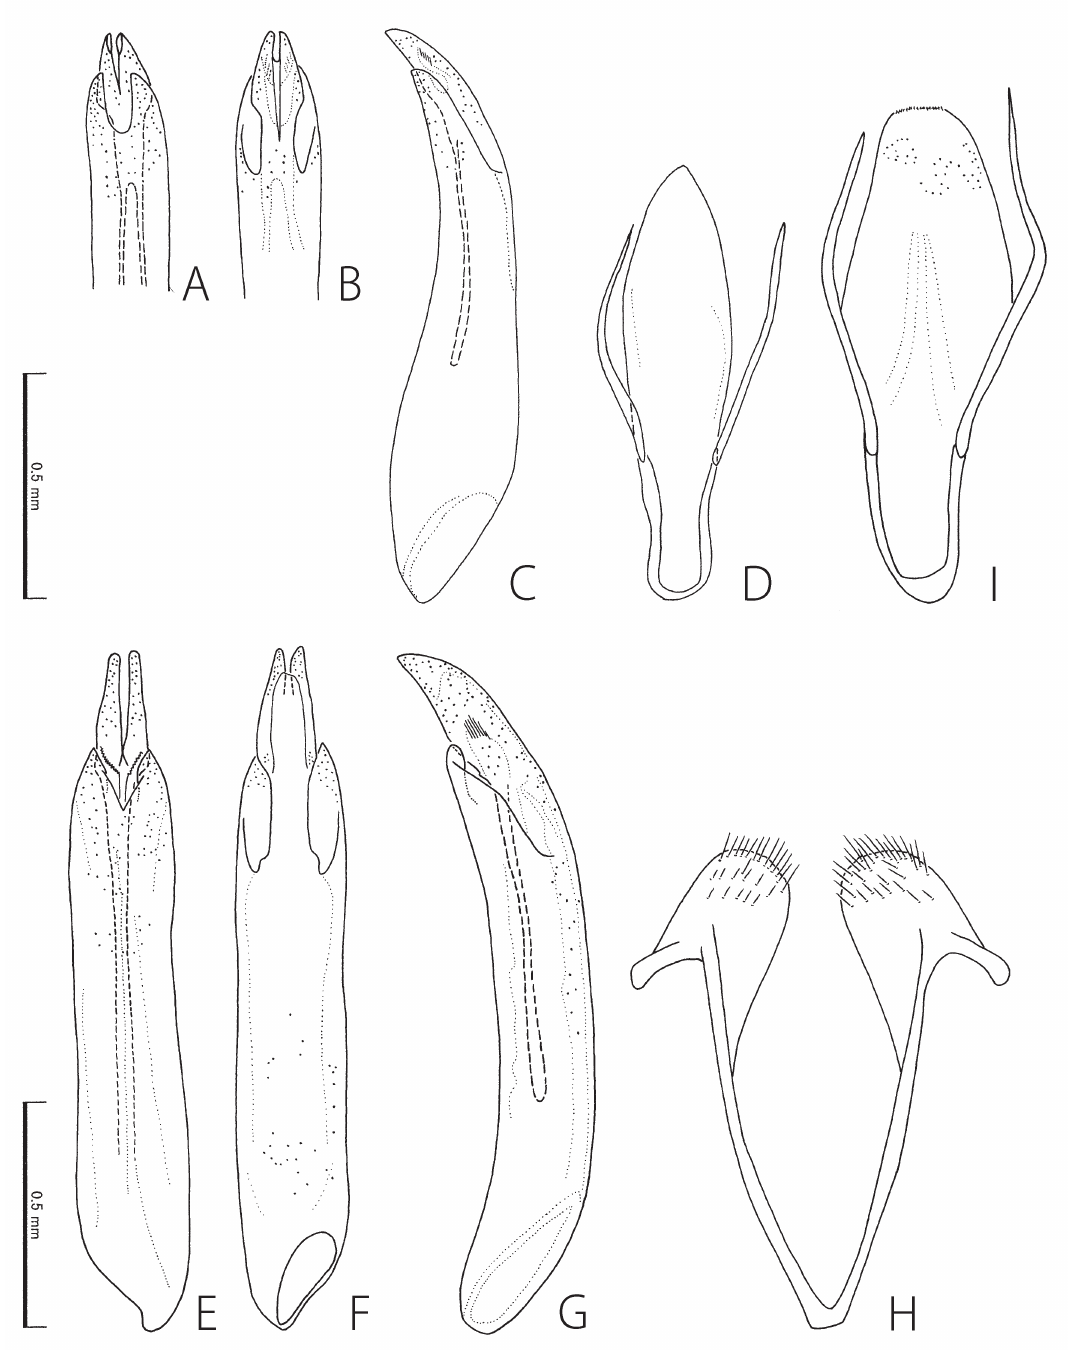
Fig. 3. Male genitalia of Caccothryptus spp. A–D . Caccothryptus tibetanus sp. nov. E–I . C . chayuensis sp. nov. — A–C , E–G . Aedeagus in ventral (A, E), dorsal (B, F) and lateral (C, G) views. H . Sternite VIII. D , I . Sternite